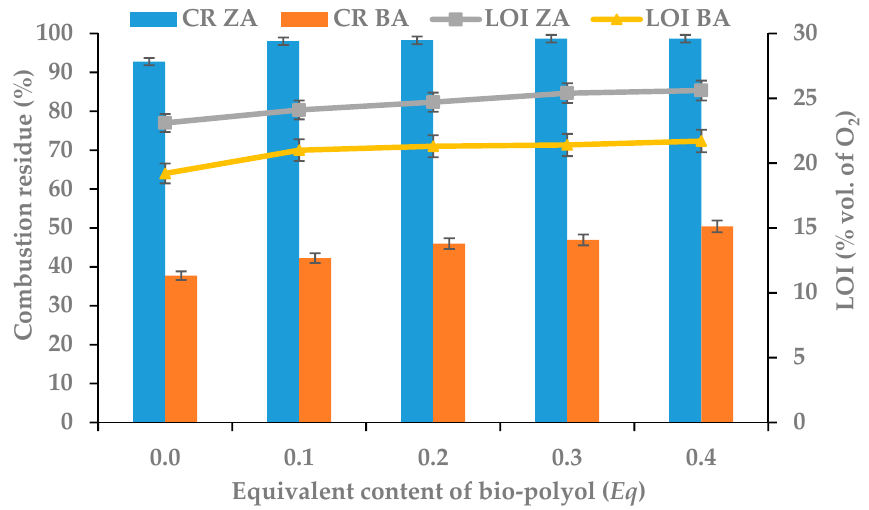
Figure 7. Dependence between bio-polyol content, combustion residue (CR) and limiting oxygen index (LOI).